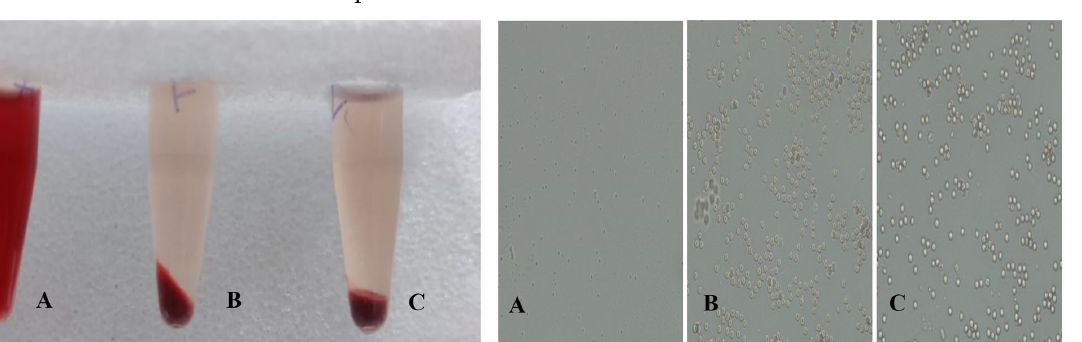
Figure 9. Microscopic images of the cornea exposed to ( A ) negative control (STF, pH 7.4); ( B ) posi ‐ tive control (IPA, 75% v/v ); ( C ) blank dual ‐ responsive in situ gel and ( D ) NEB ‐ loaded dual ‐ respon ‐ sive in situ gel.